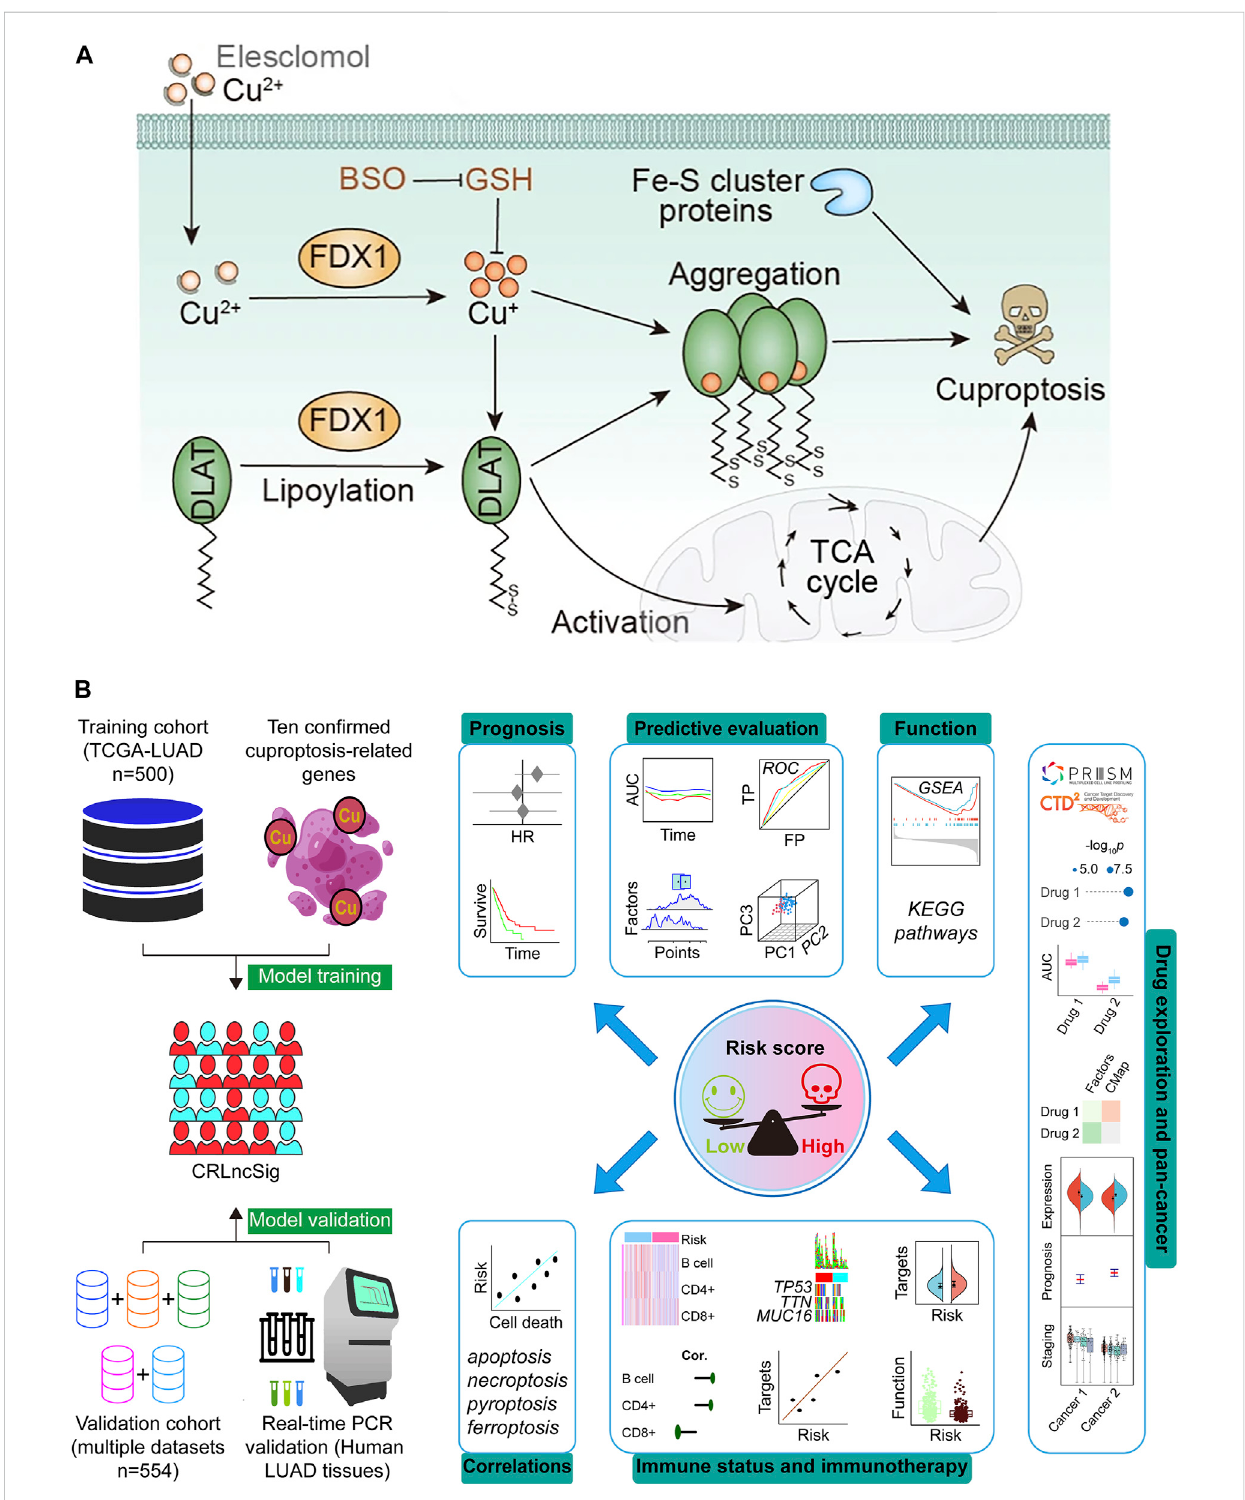
FIGURE 1 Schematic illustration indicates the mechanism of cuproptosis induction (A) (Hu et al., 2022; Tsvetkov et al., 2022) and research design (B) . DLAT, dihydrolipoamide S-acetyltransferase; FDX1, ferredoxin-1; Fe – S, iron – sulfur; TCA, tricarboxylic acid; GSH, Glutathione; BSO, buthionine sulfoximine; CRLncSig, cuproptosis-regulated lncRNA signature; TCGA, The Cancer Genome Atlas; LUAD, lung adenocarcinoma; HR, hazard ratio; ROC, receiver operating characteristic; TP, true positive rate; FP, false positive rate; AUC, area under the ROC curve; PC, principal component; KEGG, Kyoto Encyclopedia of Genes and Genomes; GSEA, Gene Set Enrichment